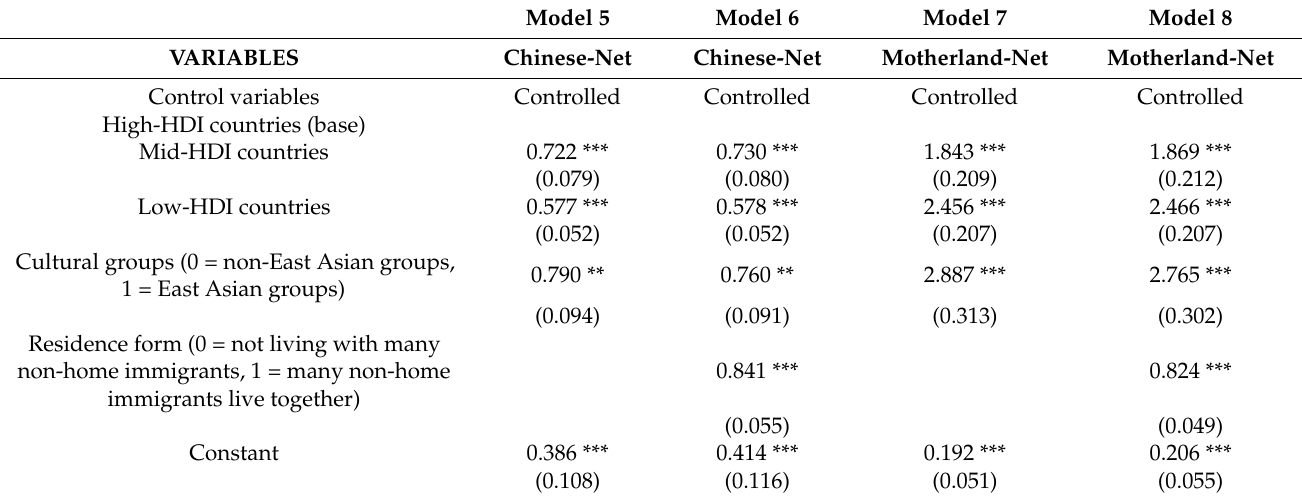
Table 2. Robustness test of migration network differences (N =